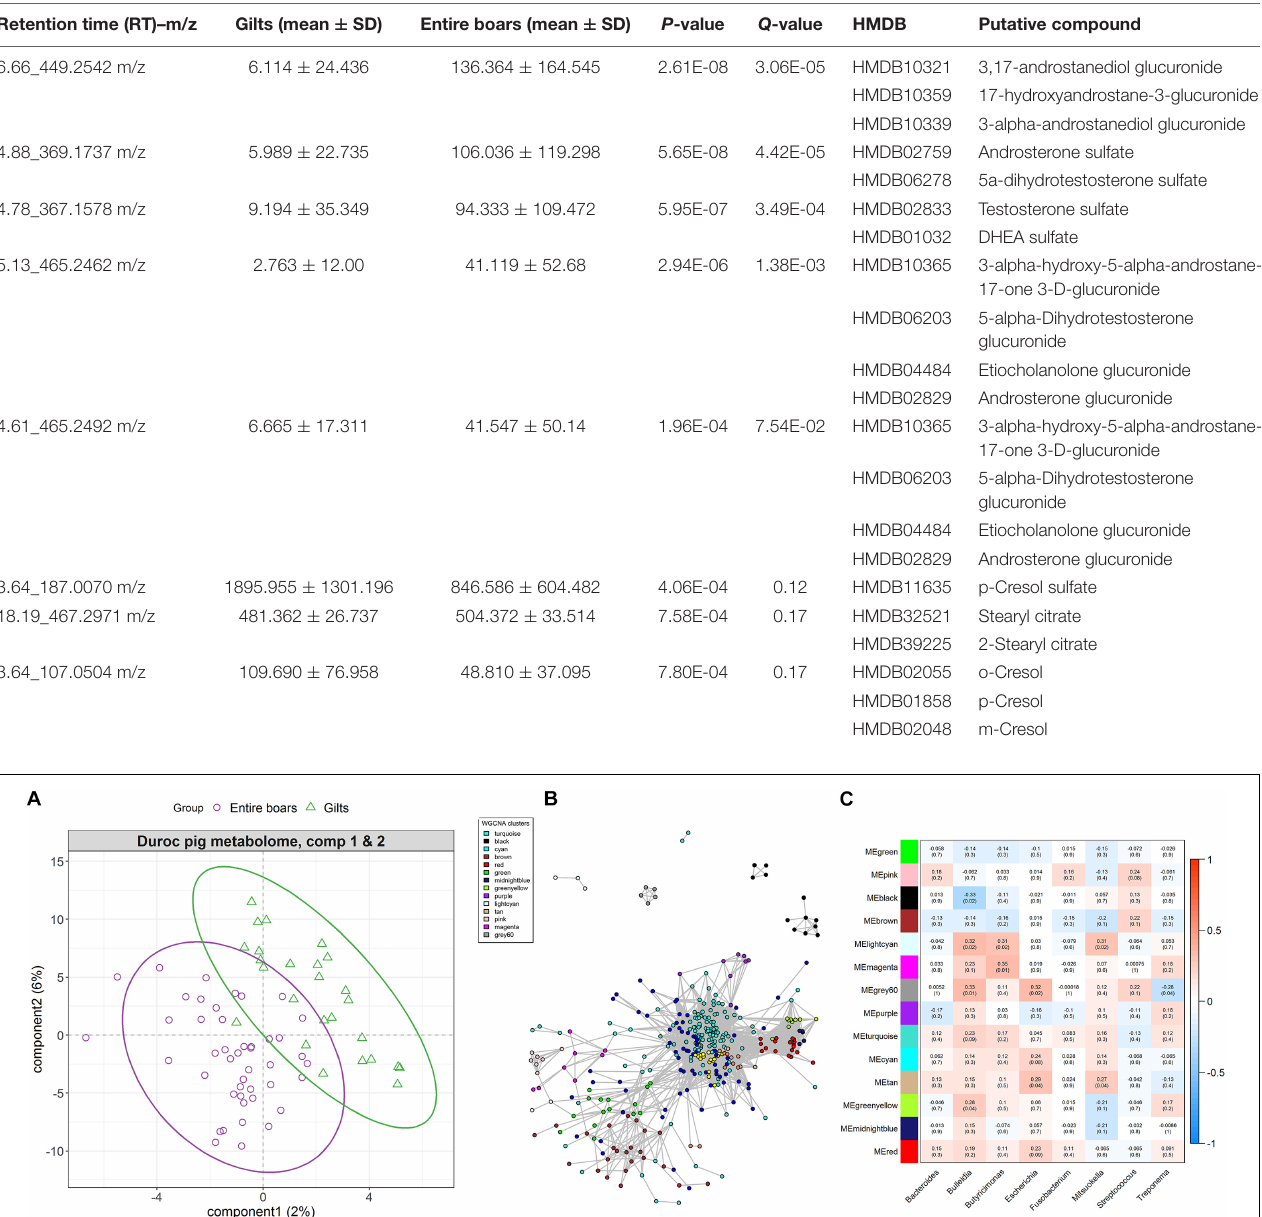
TABLE 1 | Metabolites showing distinct abundance between entire boars and gilts.